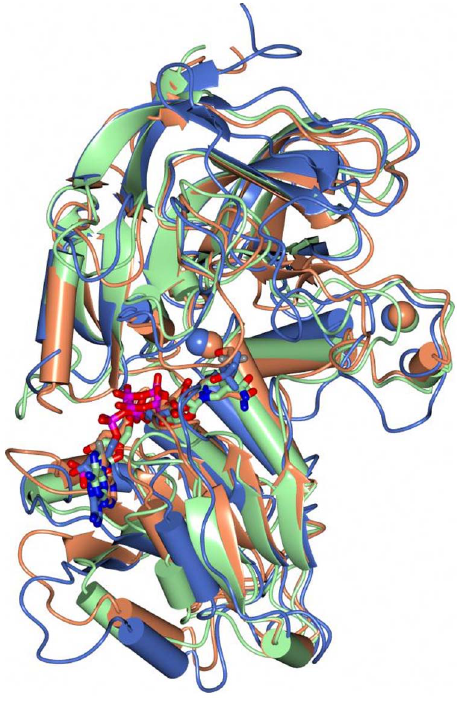
Figure 5. Superposition of ADH-NADPH (green) with YADH (coral, PDB 2HCY) and HADH (blue, PDB 5ADH). Active site ligands are drawn as cylinders and Zn 2 + ions are represented as spheres.